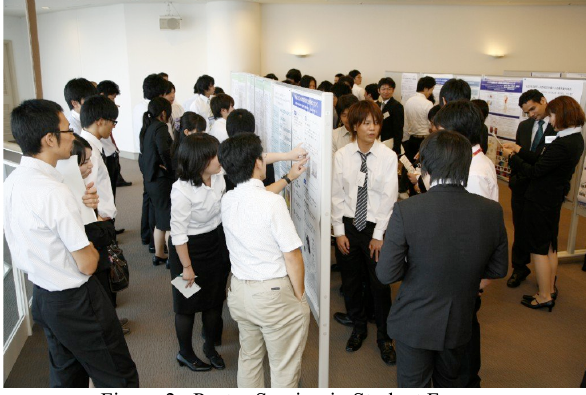
Figure 2. Poster Session in Student